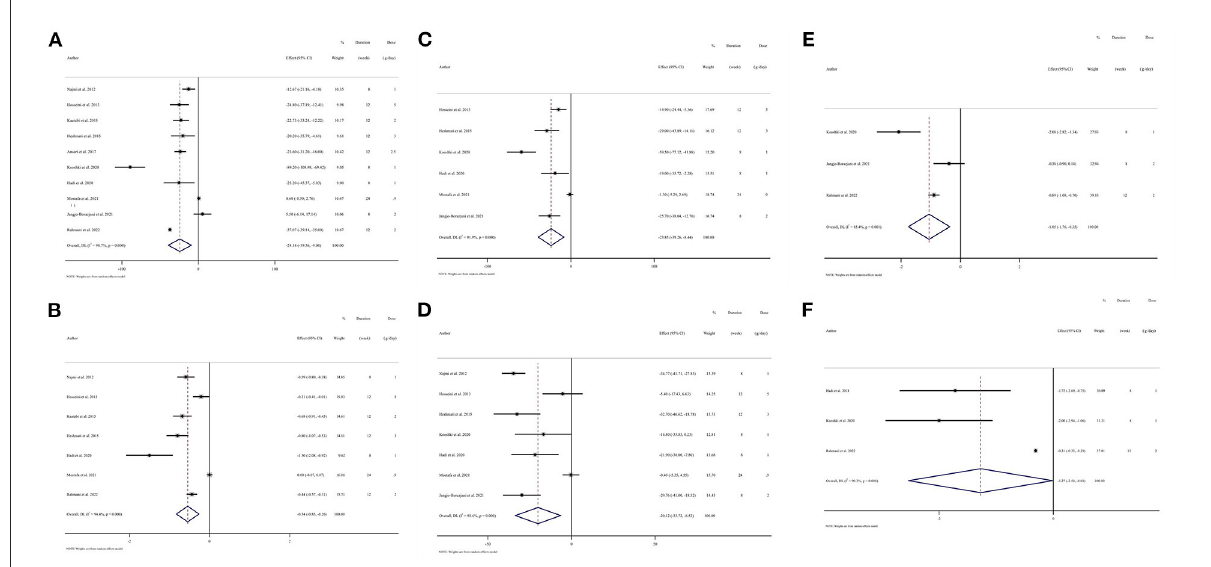
FIGURE2 Forest plots of randomized controlled trials illustrating weighted mean difference (WMD) in biomarkers between the intervention and placebo groups for all eligible studies in overall analysis. (A) Fasting plasma glucose (FPG); (B) hemoglobin A1c (HbA1c); (C) total cholesterol (TC); (D) low-density lipoprotein cholesterol (LDL-C); (E) C-reactive protein (CRP); (F) Malondialdehyde (MDA).